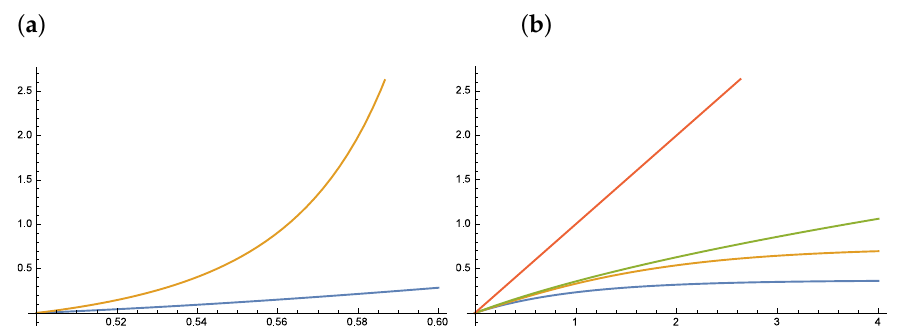
Figure 1. Exact TV distance and the upper bound for ( a ) TV(Bin ( 20, 1 TV(Pois ( 1 ) , Pois ( 1 + a ) ). ( a ) Note that the upper bound becomes useless for p 2 − p 1 ≥ 0.07; ( b ) blue and orange curves – exact TV distance: the blue curve works for 1 ≤ λ 2 ≤ 4. Note that the linear upper bound (red curve) is not relevant and the square root upper 2 ≤ λ 2 λ 1 (green curve) bound becomes useless for λ 2